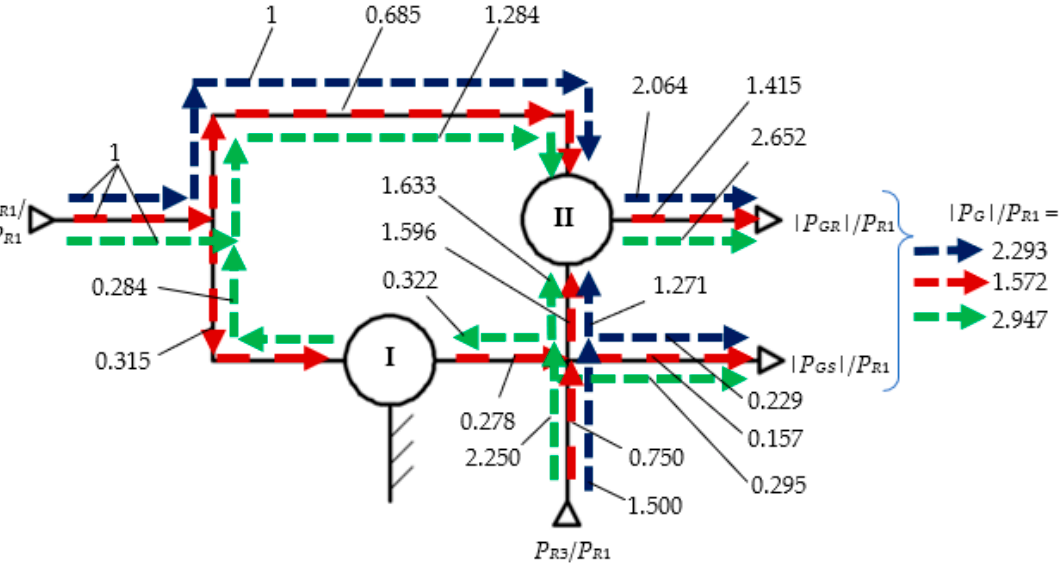
= 0.5 k (red), 1 (blue) t